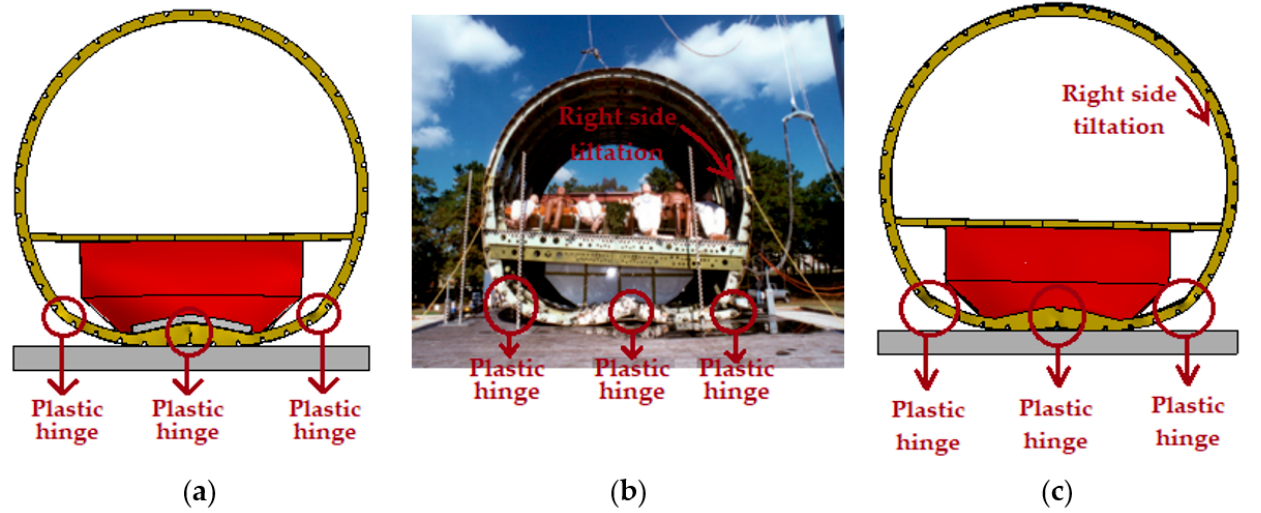
Figure 7. Post ‐ crash front view of the fuselage sections: ( a ) Reinforced fuselage; ( b ) Experimental Boeing 737 fuselage [41] ( c ) Traditional fuselage for the present study.